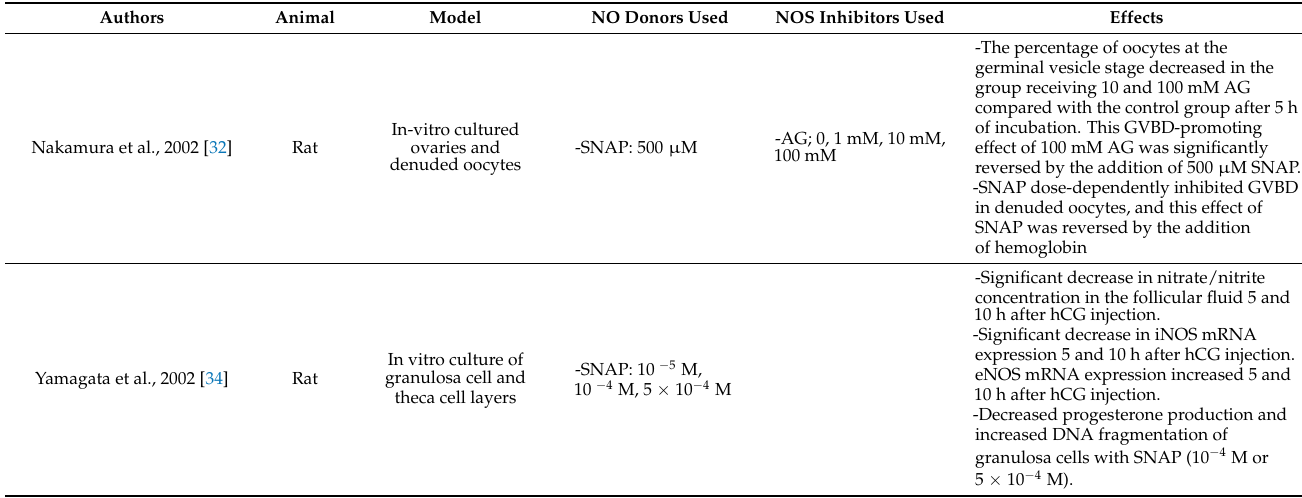
Table 3. NO and oocyte